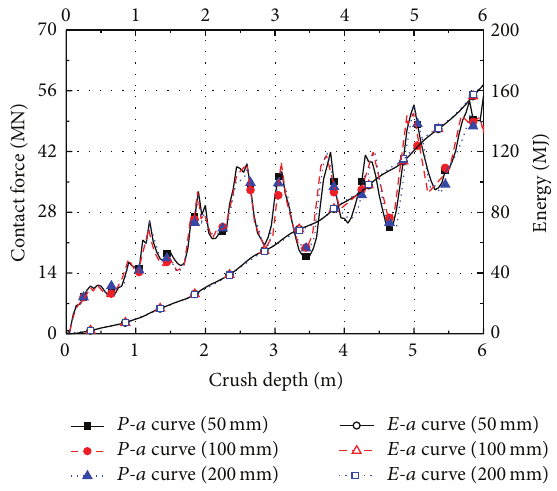
Figure 4: Comparison of the results for different mesh sizes.